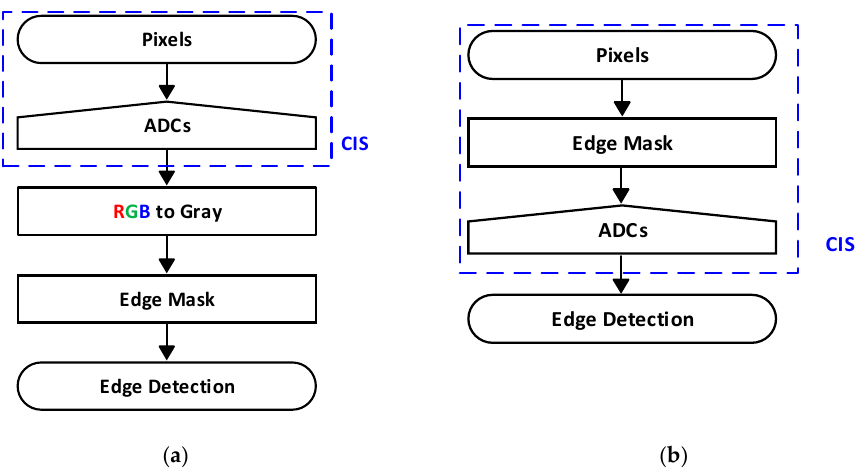
Figure 1. System flow charts: ( a ) conventional edge detection; and ( b ) the proposed edge detection system.